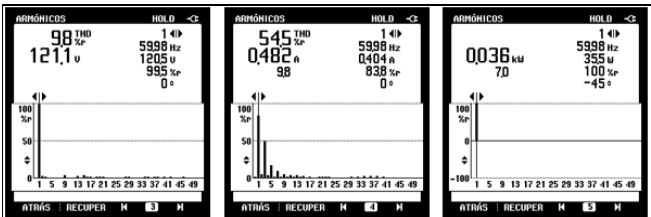
Figure 18: Harmonic components obtained by Fluke 43B analyzer in multilevel inverter with inductive-resistive load. Source: Authors,